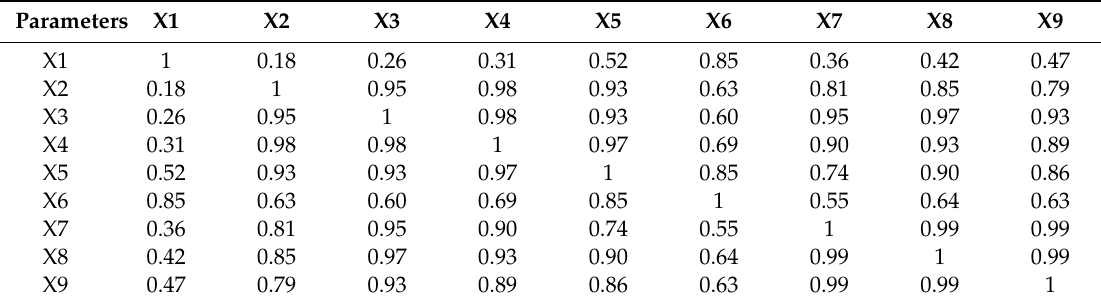
Table 7. Correlation coe ffi cient matrix.